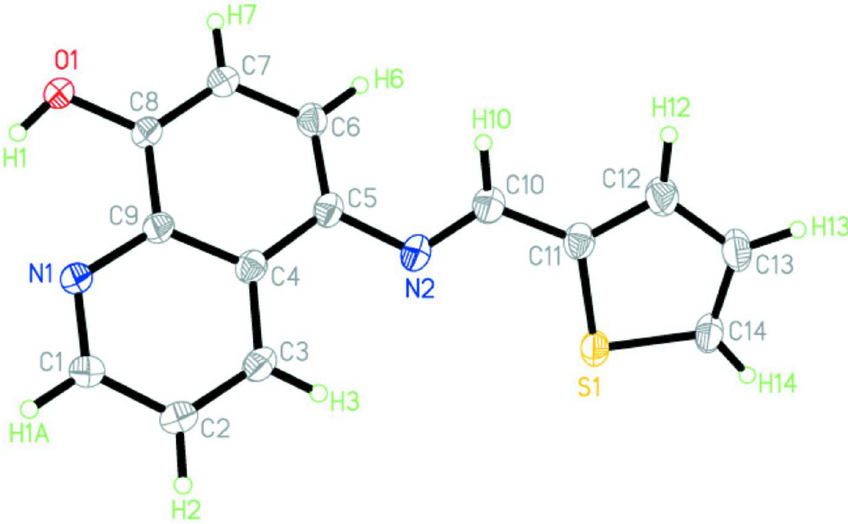
Figure 1 ORTEP representation of (I) with the numbering scheme adopted (Farrugia 1997). Ellipsoids drawn at 30% probability level.